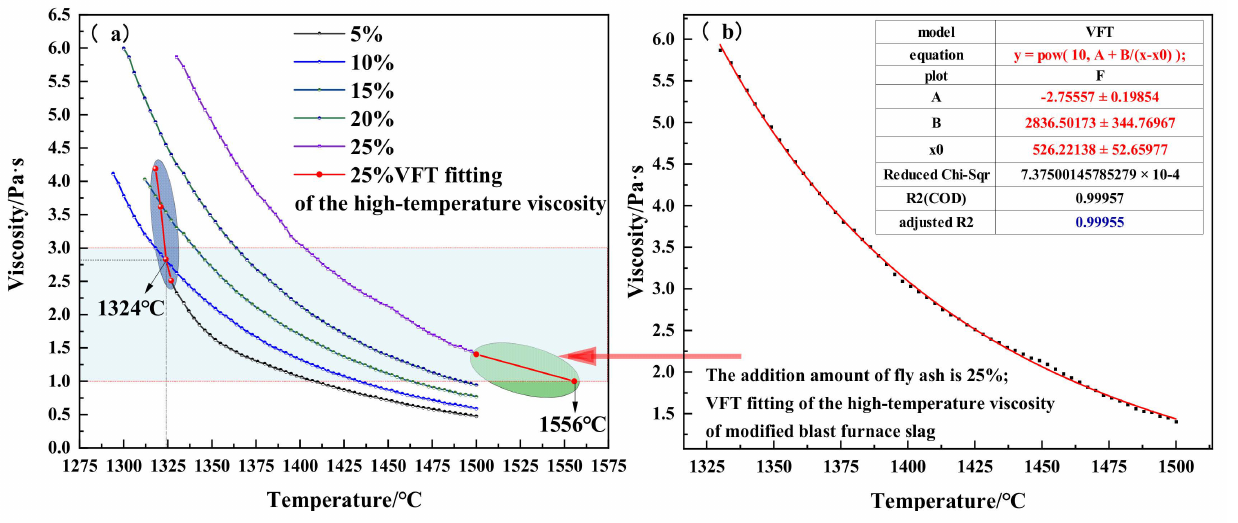
Figure 2. ( a ) Viscosity-temperature curve of modified blast furnace slag ( b ) and its VFT fitting when the amount of fly ash added is